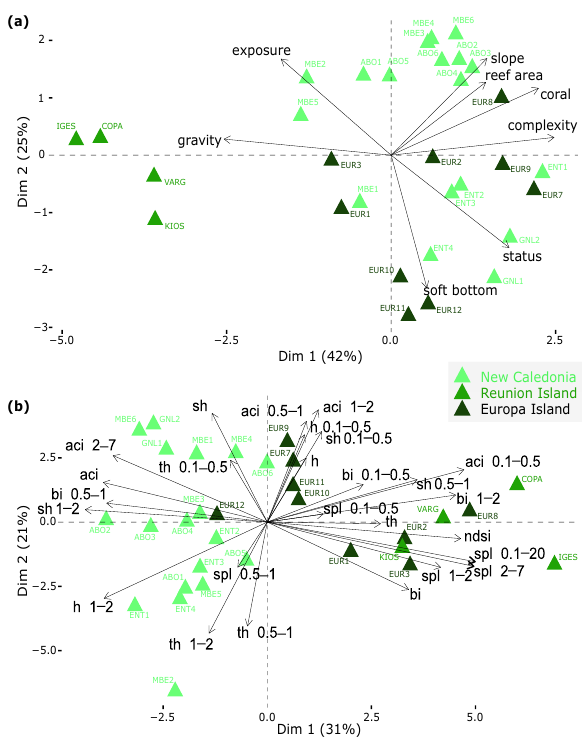
Figure 4. Principal Component Analyses showing the variance among sites when considering alternatively ( a ) the eight environmental variables (see variables meaning in Section 2.3); and ( b ) the twenty-six acoustic metrics (see variables meaning in Section 2.4) considered in this study. NC: New Caledonia; RUN: Reunion Island; EUR: Europa